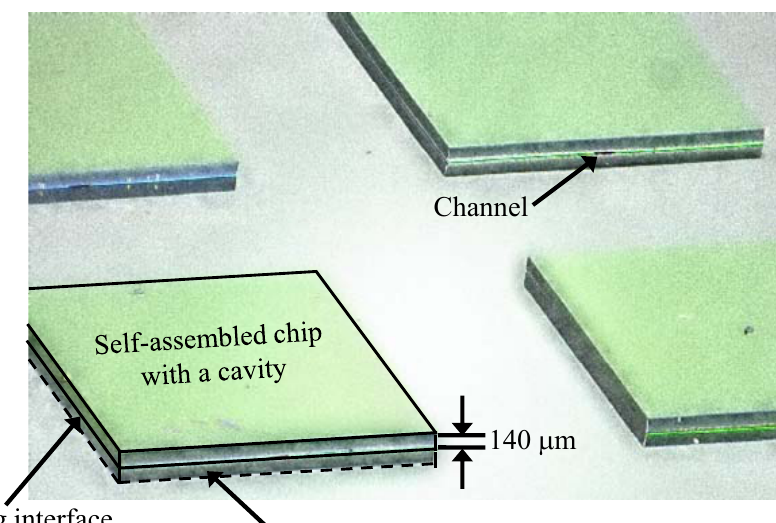
Figure 8. A photomicrograph of the self-assembled chips having cavity structures to the Si substrate with